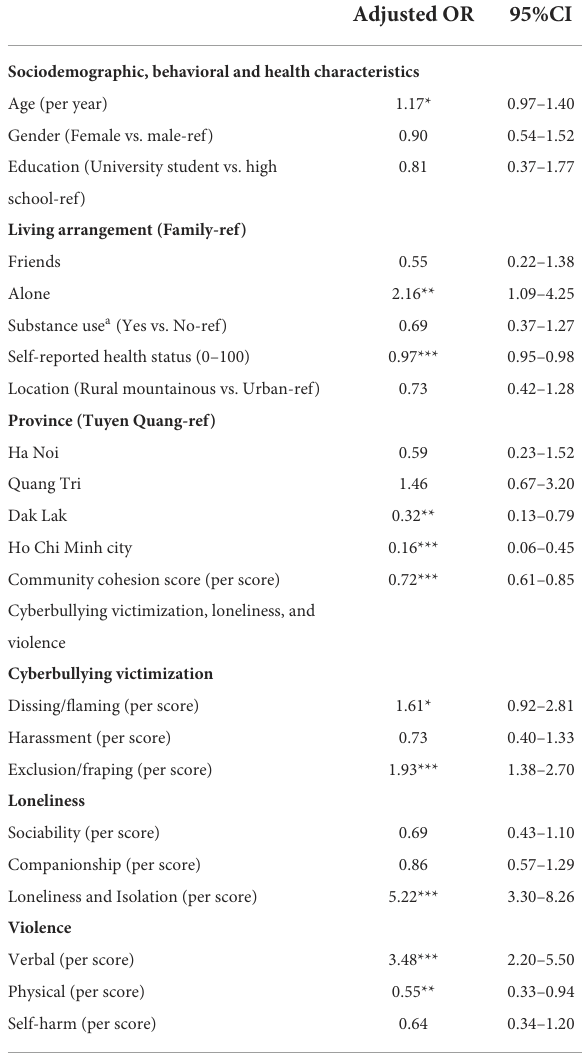
TABLE 4 Associated factors with depressive